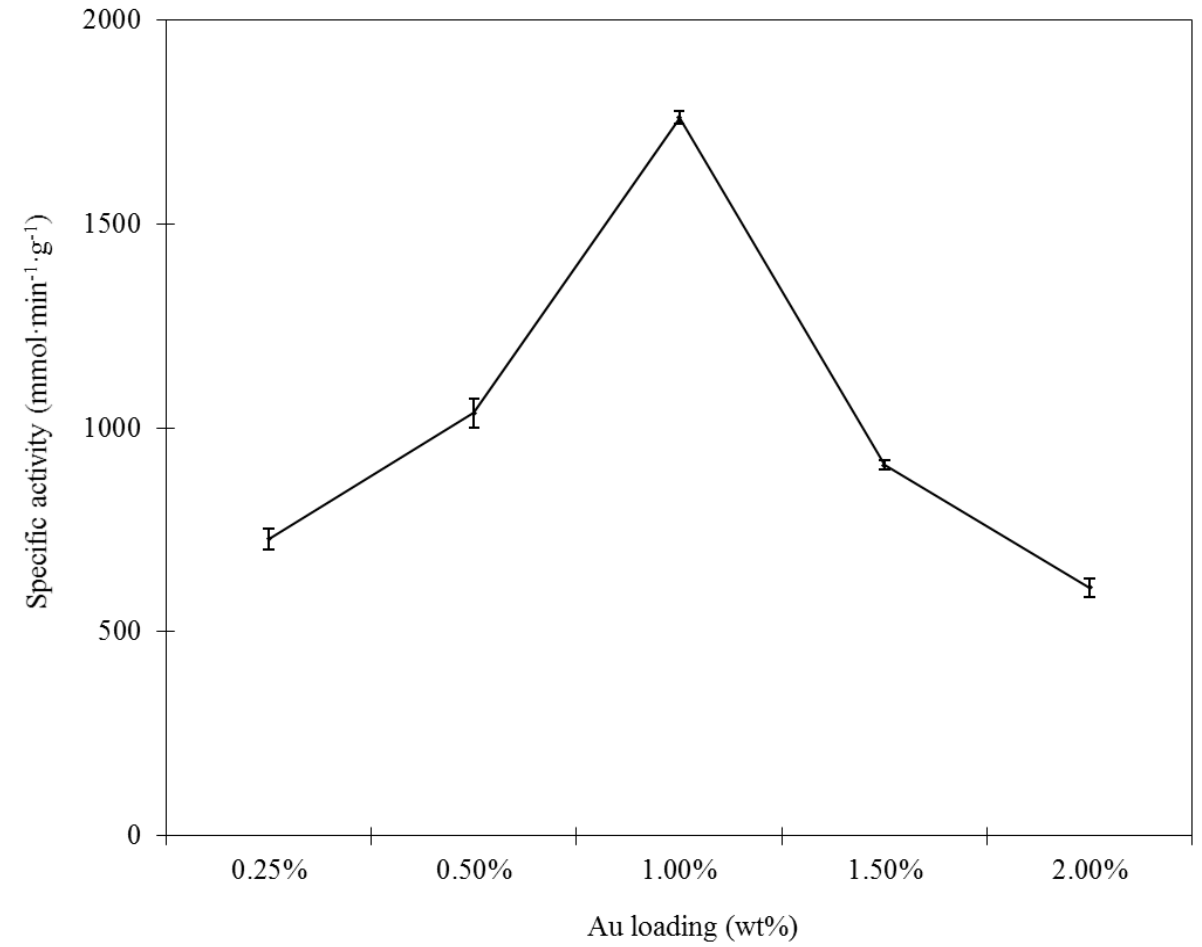
Figure 1. The specific activity of Au/Al 2 O 3 catalysts with different Au